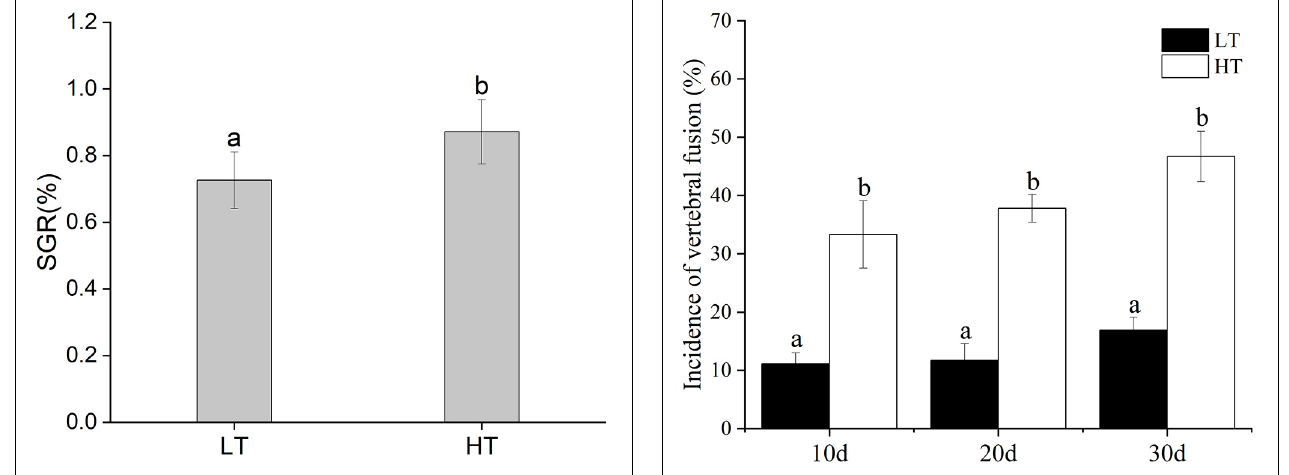
day ( Figure 5E ). MMP13 was significantly up-regulated on the 10th day and down-regulated on day 20 and 30 ( Figure 5F